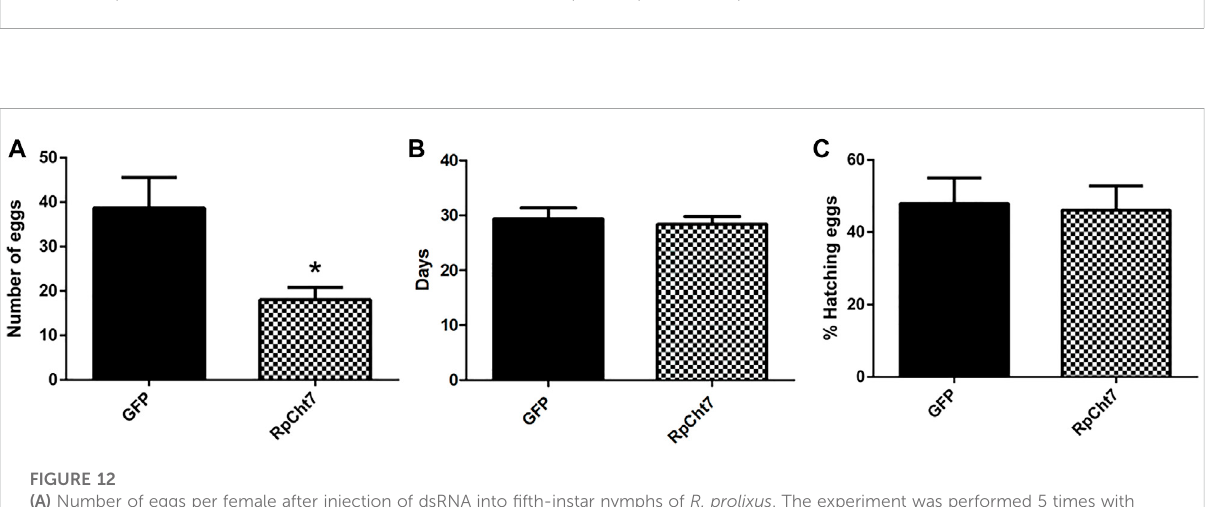
FIGURE 11 Averageeggslaidper R.prolixus femaleatdifferenttimesafterbloodfeeding.Inblack,insectsinjectedwithds GFP .Ingray,insectsinjectedwith ds RpCht7 . (A – D) aredifferentexperimentreplicates. (A) 9ds GFP femalesand4ds RpCht 7females; (B) 16femalesineachgroup; (C) 7ds GFP females and 13 ds RpCht7 females; (D) 12 females ds GFP and 13 females ds RpCht7 . * p < 0.05, unpaired T-test.